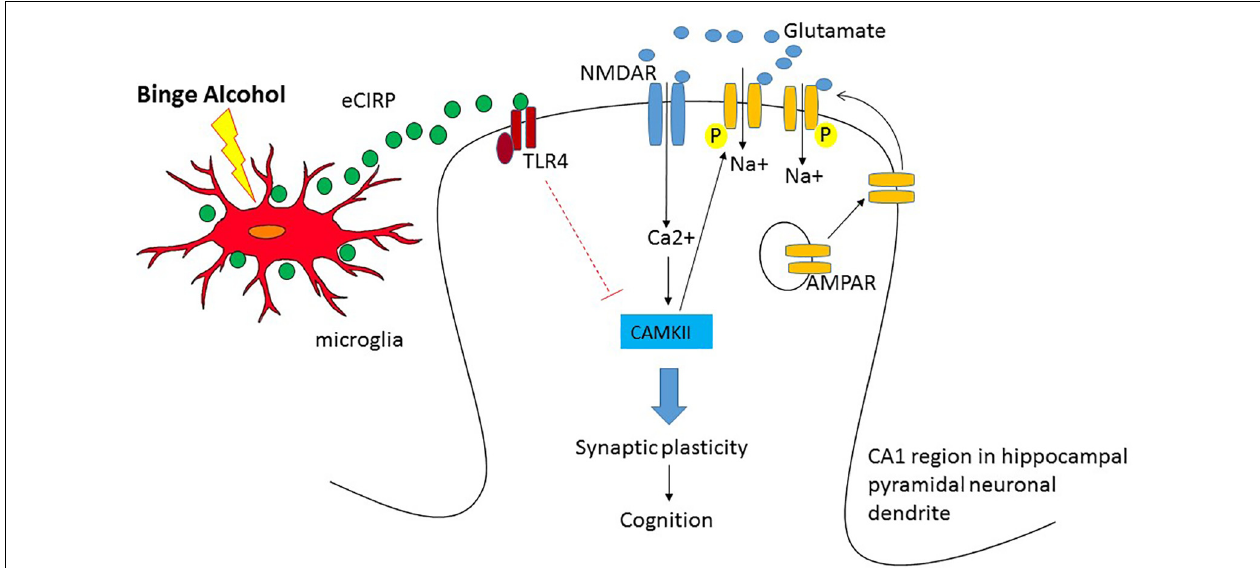
FIGURE 1 | Potential mechanism of hypometabolism and impaired cognition after acute alcohol intoxication in the pyramidal neurons of the CA1 region in hippocampus. When glutamate is released from the pre-synaptic terminal, NMDA receptor (NMDAR), the inotropic channel, opens and allows the entry of Ca 2 + into the post-synaptic terminal and depolarizes the cell. The entry of Ca 2 + activates Ca/Calmodulin Kinase II (CAMKII) and facilitates phosphorylation and trafficking of AMPAR into the cell membrane causing sustained depolarization and long term synaptic potential leading to cognition. Upon binge alcohol exposure, cold inducible RNA binding protein (CIRP) released from microglia binds to Toll like receptor 4 (TLR4) and the activation of the TLR4 pathway presumably decreases the expression of CAMKII and attenuates synaptic plasticity leading to cognitive impairment.